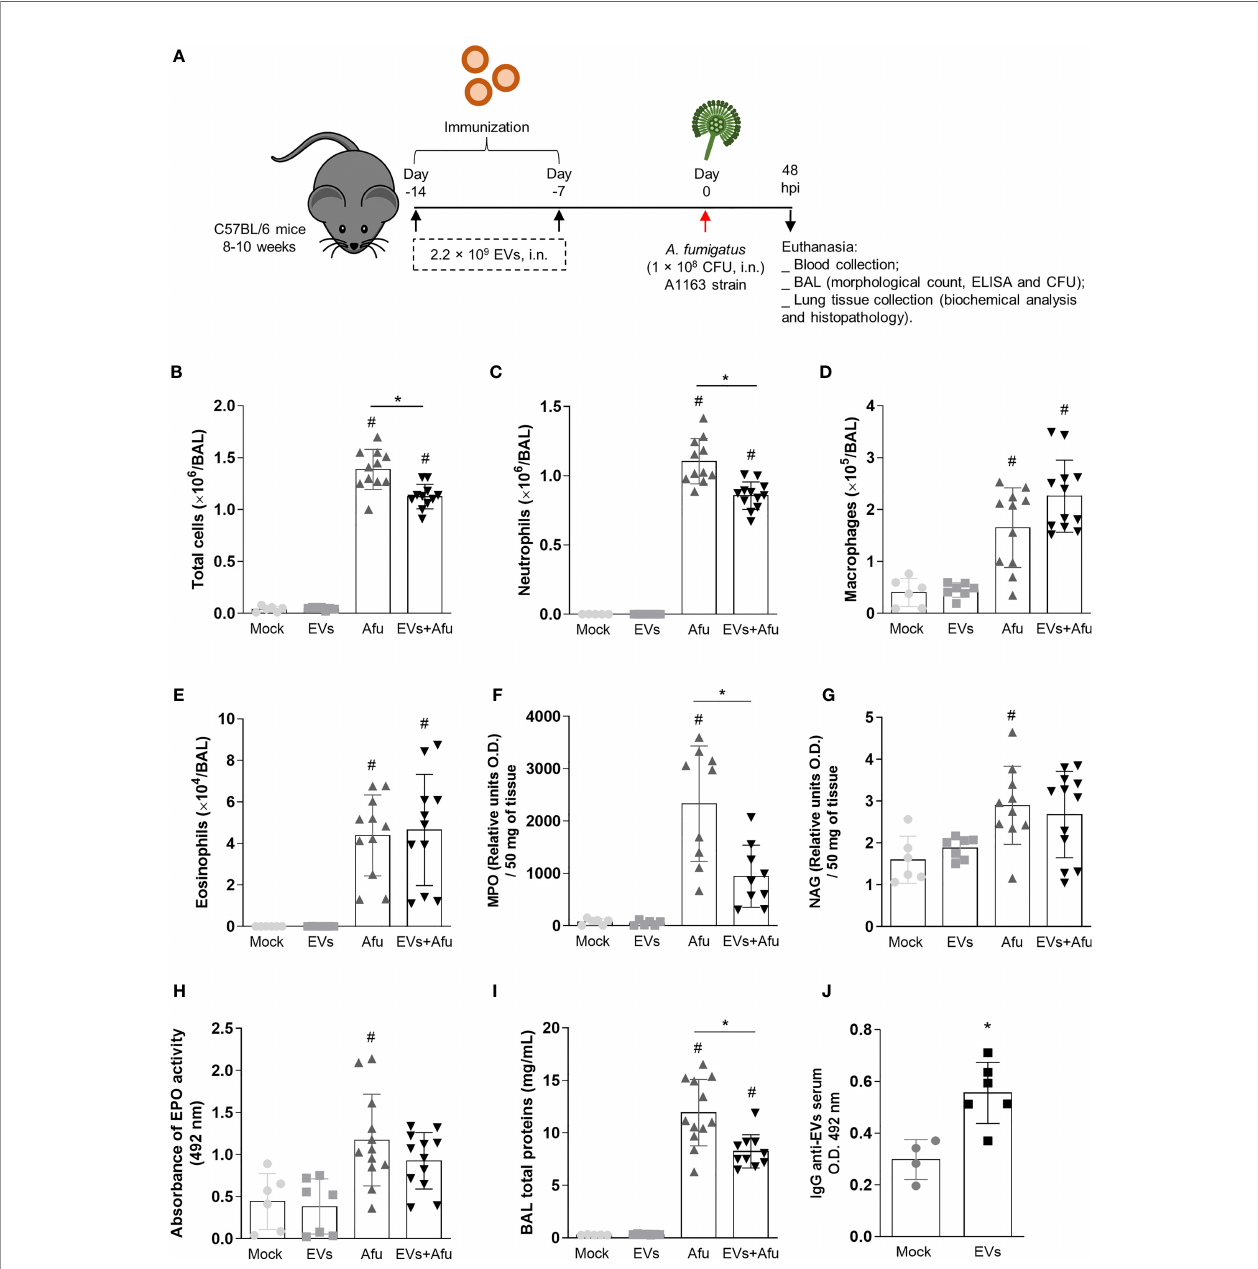
FIGURE 1 | Immunization with A. fumigatus EVs stimulates the production of antibodies and modulate in fl ammatory in fi ltrate to lungs during infection. C57BL/6 WT mice were immunized twice with EVs (2.2 × 10 9 EVs/immunization, i.n.), challenged intranasally with 1 × 10 8 A. fumigatus conidia 14 th day and euthanized 48 h later (schematic protocol in (A) . BAL was harvested to quantify numbers of leukocytes (B) , neutrophils (C) , macrophages (D) and eosinophils (E) . MPO (F) , NAG (G) and EPO (H) activity in lung tissue. The total protein level in BAL is shown in (I) . Blood was collected to assess the production of IgG reactive to EVs (J) . Data are mean ± SD of N = 5-6 animals per group. #/* P < 0.05 when compared to the Mock group (#) or as indicated (*), as determined by One Way-ANOVA and two- sample independent t-tests. Data are representative of two